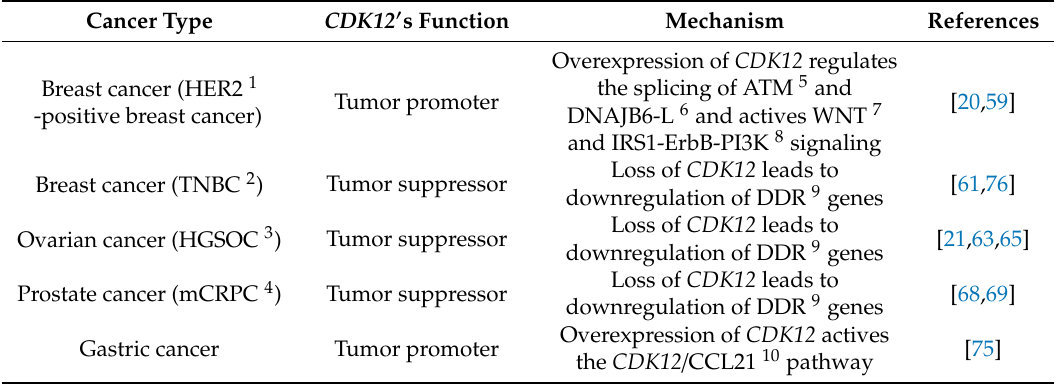
The role of cyclin-dependent kinase 12 ( CDK12 ) in various cancers and the associated